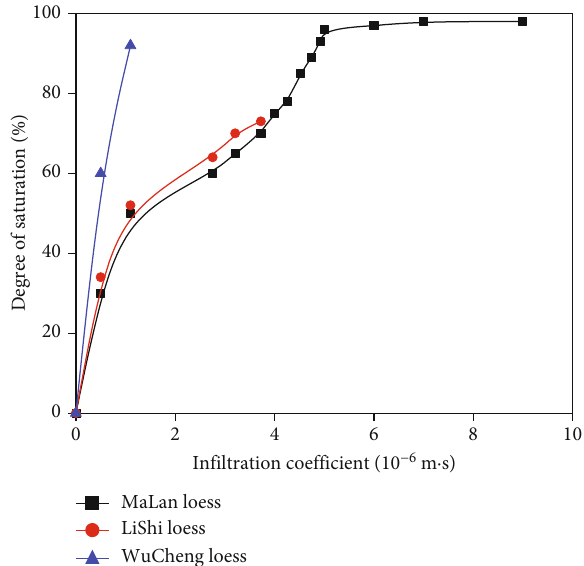
Figure 4: Characteristic curves of the hydraulic in fi ltration coe ffi cient.